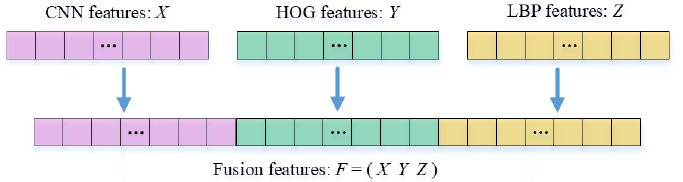
Figure 11. The procedure of the multi-feature fusion strategy.